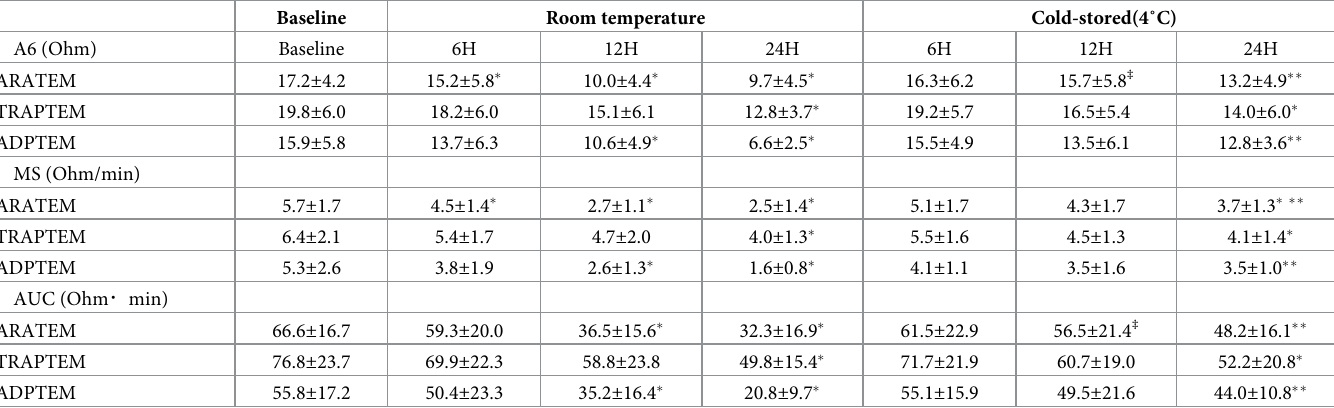
Table 1. The effect of storage conditions on platelet aggregation parameters ( n =